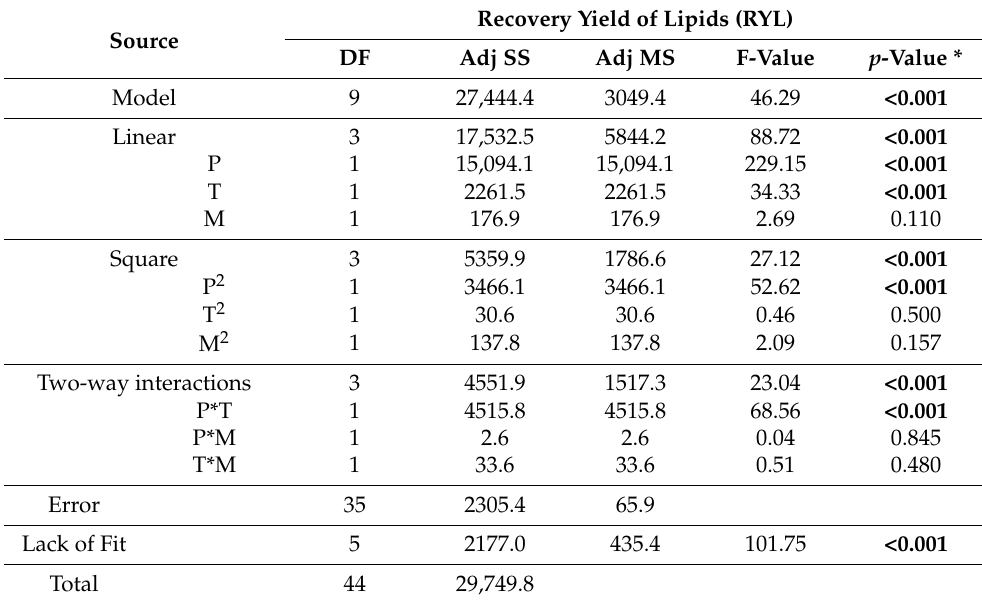
Table 3. ANOVA analysis of Recovery Yield of Lipids for SC-CO 2 extraction of SCG. Recovery Yield of Lipids (RYL) Source DF Adj